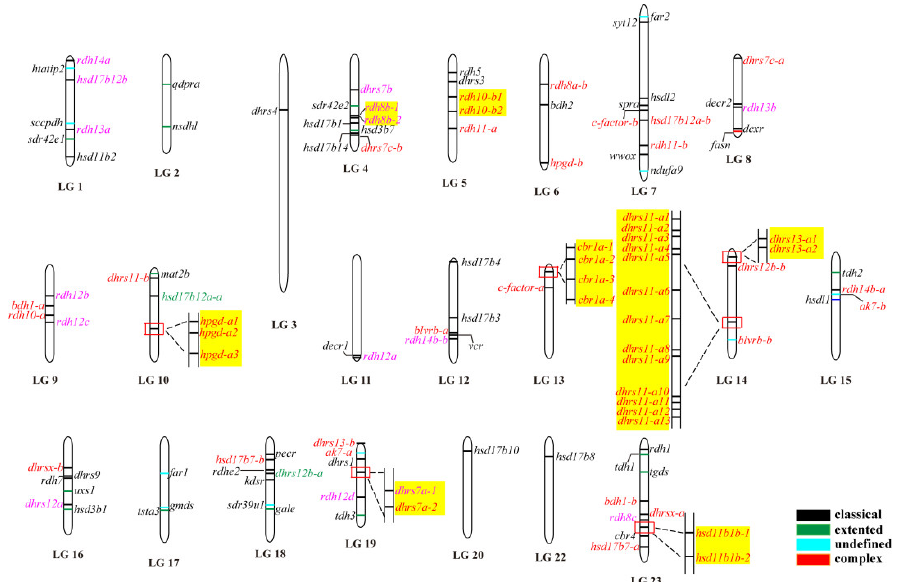
Figure 2. Chromosomal maps of the SDR s in Nile tilapia. SDR s were depicted on linkage group (LG) of the genome. LG21 is absent because it was combined with LG16. Black, green, blue, and red horizontal lines indicate classical, extended, atypical, and complex SDR s, respectively. Gene names in pink and red indicate genes derived from 2R and 3R events, respectively, whereas gene names in green represent it undergoing both 2R and 3R events. Gene name in black is a single copy gene. Tandem duplicates are highlighted in a yellow shade.